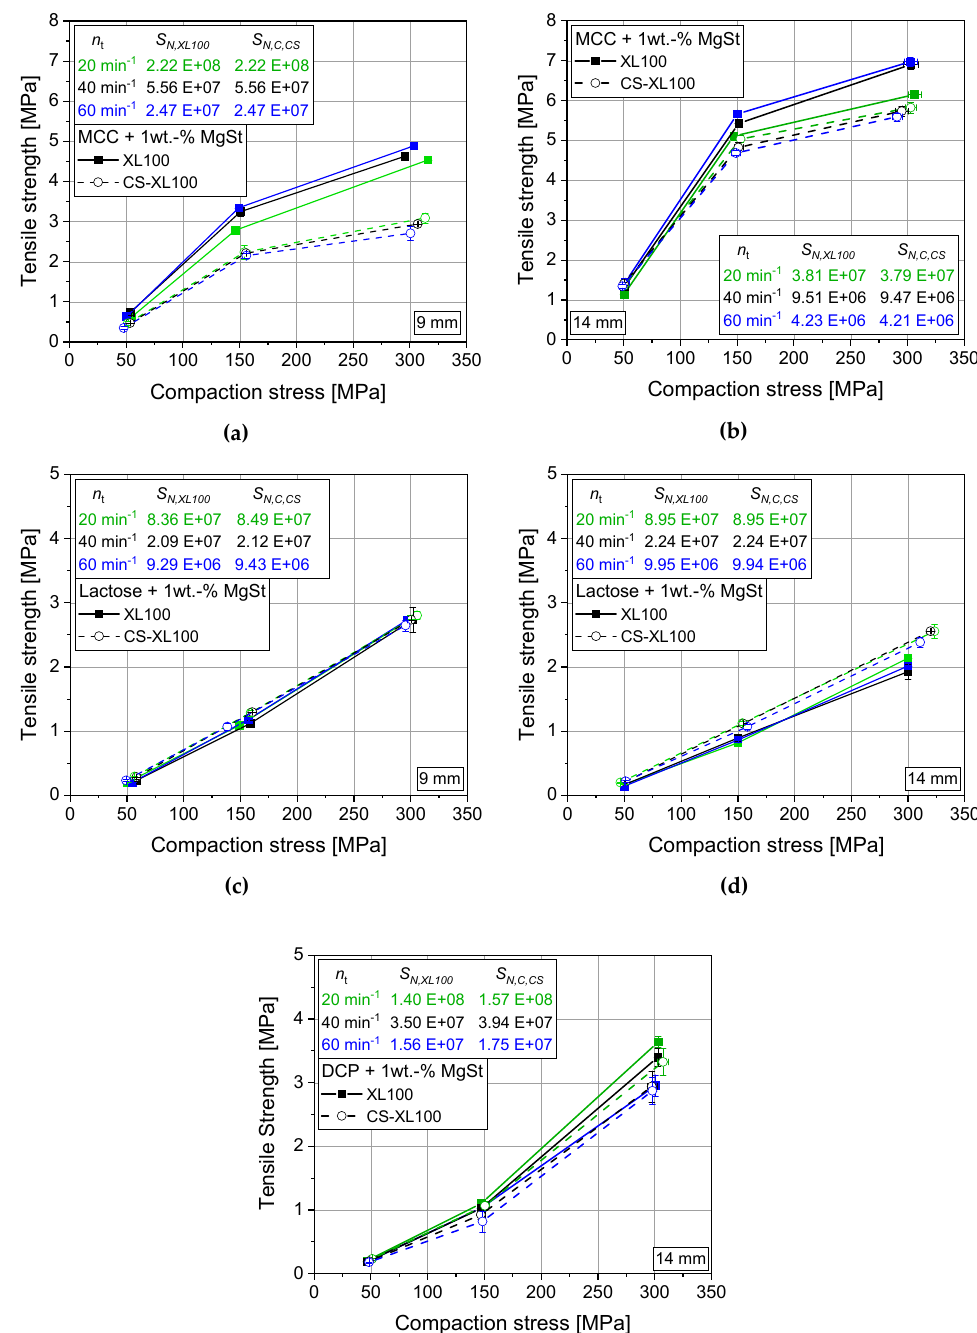
Figure 10. Tabletability profile of lubricated powders (1 wt.-% MgSt) for an XL100 and its simulated profile (CS) by applying optimized feeder rotation frequency using the CS-adapted shear number S N , CS for MCC applying 9 mm punches ( a , n p,XL100 = 60 min − 1 , n p,CS = 128 min − 1 ) and 14 mm punches ( b , n p,XL100 = 60 min − 1 , n p,CS = 128 min − 1 ), lactose applying 9 mm punches ( c , n p,XL100 = 24 min − 1 , n p,CS = 52 min − 1 ) and 14 mm punches ( d , n p,XL100 =60 min − 1 , n p,CS = 128 min − 1 ) as well as DPC applying 14 mm punches ( e , n p,XL100 = 60 min − 1 , n p,CS = 128 min − 1 ). n = 10.